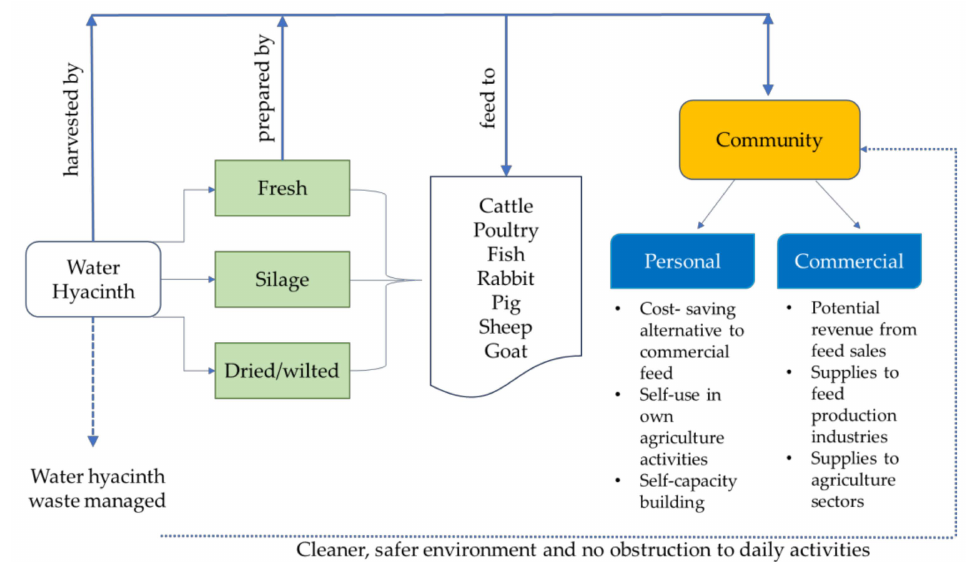
Figure 1. Water hyacinth, its animal feed potential and the benefits that can be gained by the